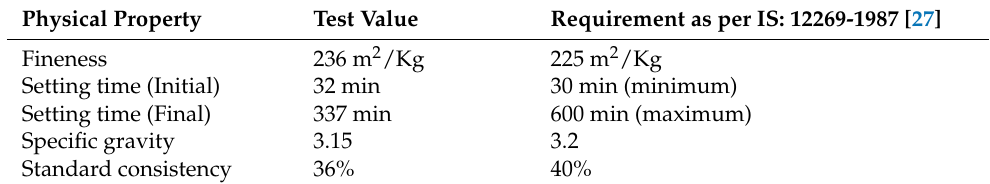
Table 1. Physical properties of ordinary Portland cement.